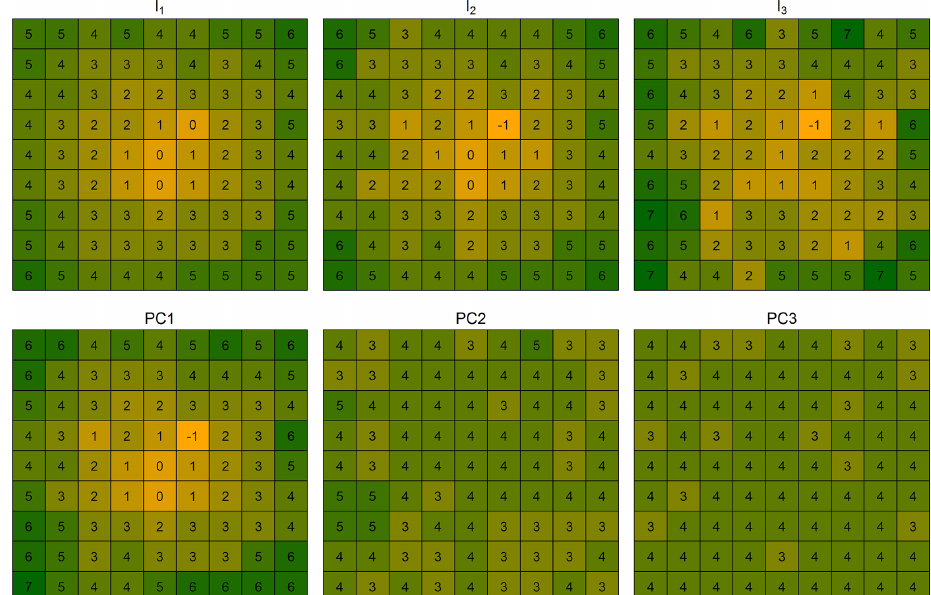
Figure 7. Principle component analysis for a designed data set. The data are the same as those for Fig. 5. The first row shows the pattern of the original data ( I 1 – I 3 ) , the second row shows the three resulting principle components (PC1–PC3). The PCs are scaled to the same numeric domain as the original data and colored alike (orange for low values; green for high values). PC1 shows the dominance of the concentric pattern, explaining 90.5% of overall variance of the data. PC2 and PC3 are more homogeneous and describe the noise of the construction of the data set.